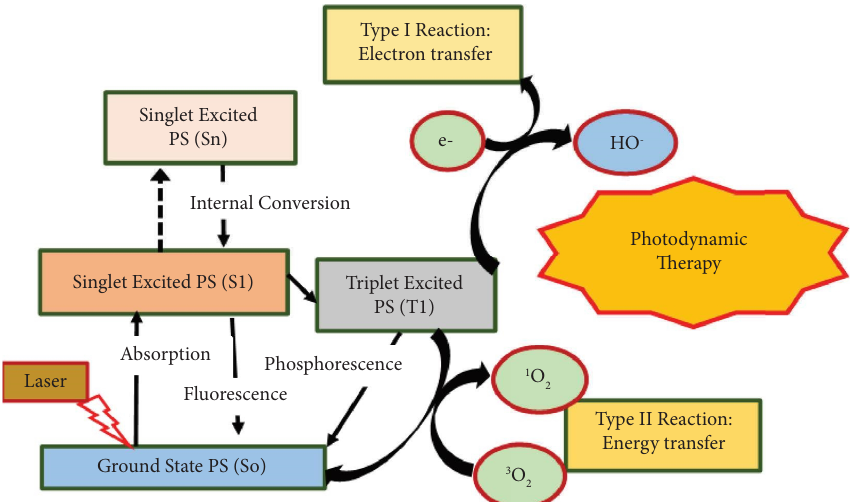
Figure 9: Mechanism of photosensitizer-mediated photodynamic cancer therapy.